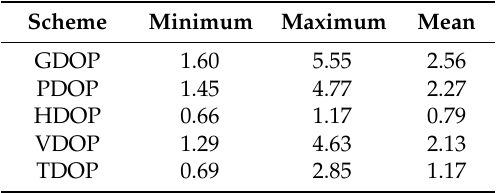
Table 2. Dilution of precision (DOP) values of different schemes (mask angle 10°).